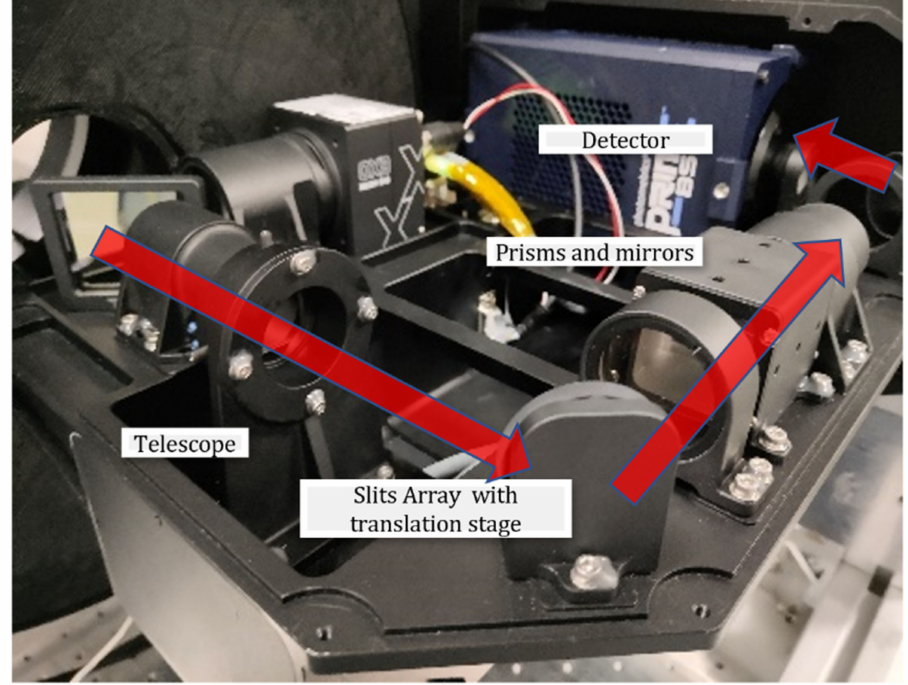
Figure 5. Prototype